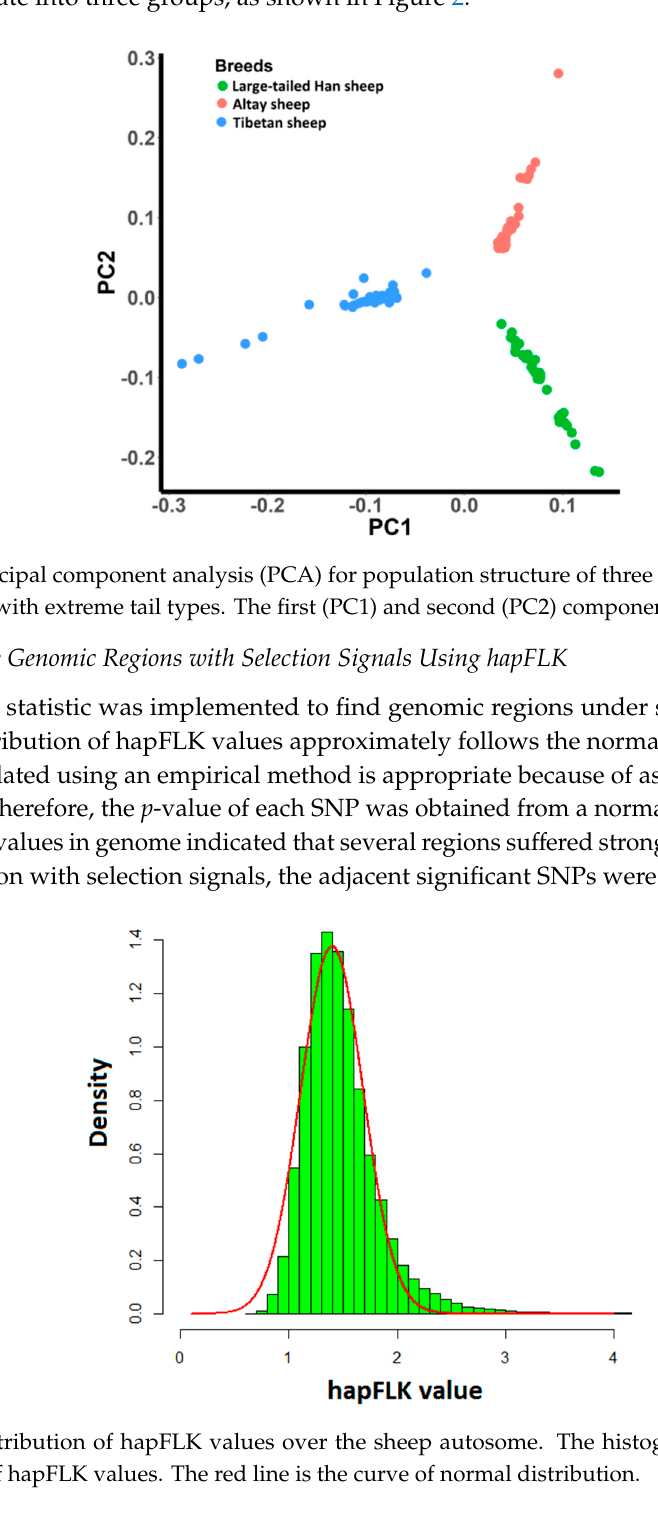
Figure 4. Manhattan plot of hapFLK values on the sheep autosome. The gray horizontal line denotes 0.01 genome-wide threshold ( − log10(0.01/500,593) = 7.77). 3.3. Candidate Genes Annotated in Selection Regions In total, we identified 25 genomic regions with selective signals, as shown in Table 2. The total length of genomic regions is 9.7 Mb. The largest length of genomic region is located on OAR10, while the genomic region on OAR1 contains the largest number of SNPs. These genomic regions harbored 73 positional candidate genes. Out of these, nine genes including WDR92 , TBX12 , WARS2 , BMP2 , VEGFA , PDGFD , HOXA10 , ALX4 , and ETAA1 have been reported as implicated with tail formation in sheep [11,13,19,20]. Moreover, three genes ( VEGFA , TBX12 , and WARS2 ) have been associated with fat distribution in waist and hip in human [21], which indicate these genes may play important role in fat deposition in sheep tails. Several genes were also identified to be associated with other economically important traits. RXFP2 has been identified as being involved in horn morphology and was considered as the major